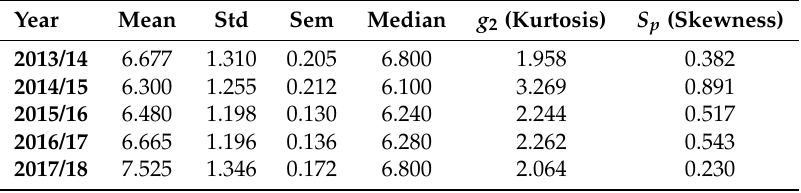
Table 9. Representative grades for each academic